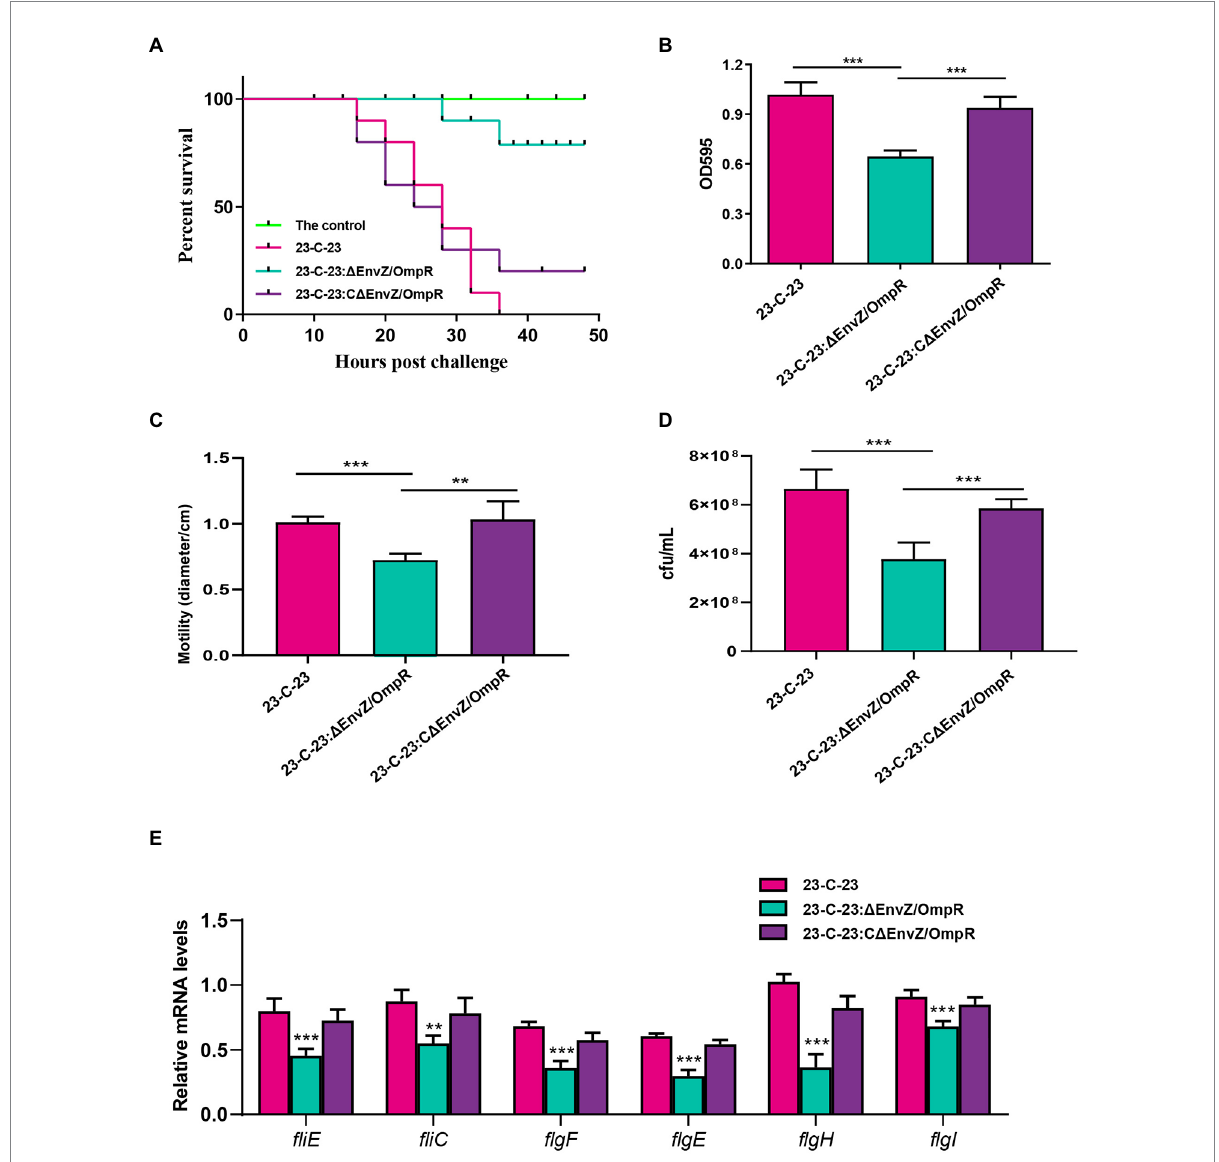
FIGURE 3 Effect of EnvZ/OmpR on the virulence of 23-C-23 . (A) Survival curves for KM mouse in experiment infection. The mice was injected intraperitoneally with 0.1 ml of each respective strain ( 23-C-23 , 23-C-23, Δ EnvZ/OmpR, and 23-C-23,C Δ EnvZ/OmpR ) at doses of 1 × 10 7 CFU. The mortality of mice was recorded. (B) Motility assay. The strains were cultured to log-phase. One microliter of bacterial suspension was spotted onto a 0.3% TSA plate, and incubated at 28 ° C for 24 h. The motility diameters of bacteria were measured. (C) Chemotaxis assay. The strains were cultured to log-phase. A capillary tube was closed at one end and filled with mucus, and the other end was dipped into the bacterial suspension. After 1 h, the liquid in the capillary was removed for counting. The number of bacteria in the capillary tube was measured. (D) Biofilm formation ability of 23-C-23 , 23-C-23: Δ EnvZ/OmpR, and 23-C-23:C Δ EnvZ/OmpR . (E) The expression levels of flagellar assembly-related genes. Values are expressed as the mean ± SD of three individual experiments. ** p < 0.01, and *** p < 0.001 compared with 23-C-23